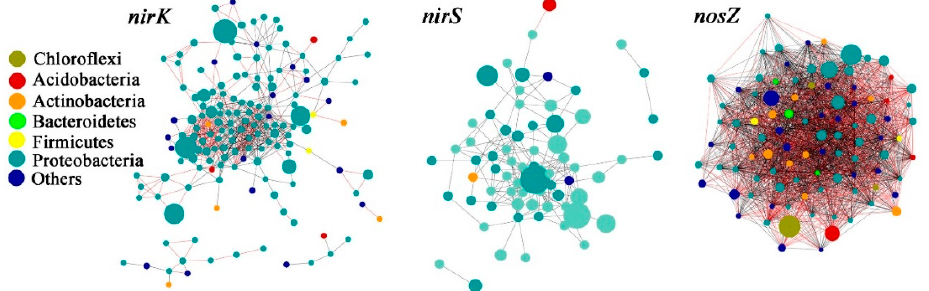
Figure 3. Species co-occurrence networks for the nirK , nirS , and nosZ gene containing bacterial communities. All OTUs from both the Acacia mangium (AM) and Pinus massoniana (PM) plantations were included in the networks. Seven bacterial phyla were represented with different colors, and the node size is proportional to the square root of the abundance of the corresponding OTU. The positive and negative correlations between the two nodes were indicated with black and red edges, respectively.